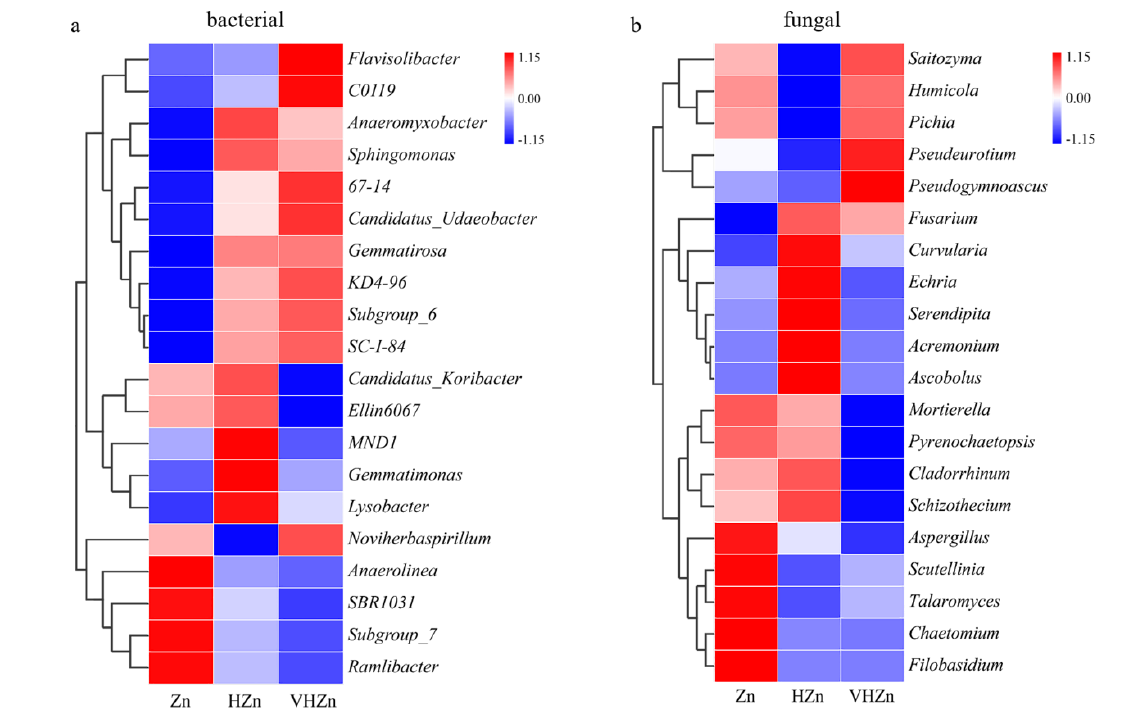
Figure 6. Hierarchical clustering heat maps of the bacterial ( a ) and fungal ( b ) communities in top 20 genera in rice rhizosphere soil with different levels of Zn (Zn: 10 mg . kg −1 soil; HZn: 200 mg . kg −1 soil; VHZn: 400 mg . kg −1 soil).